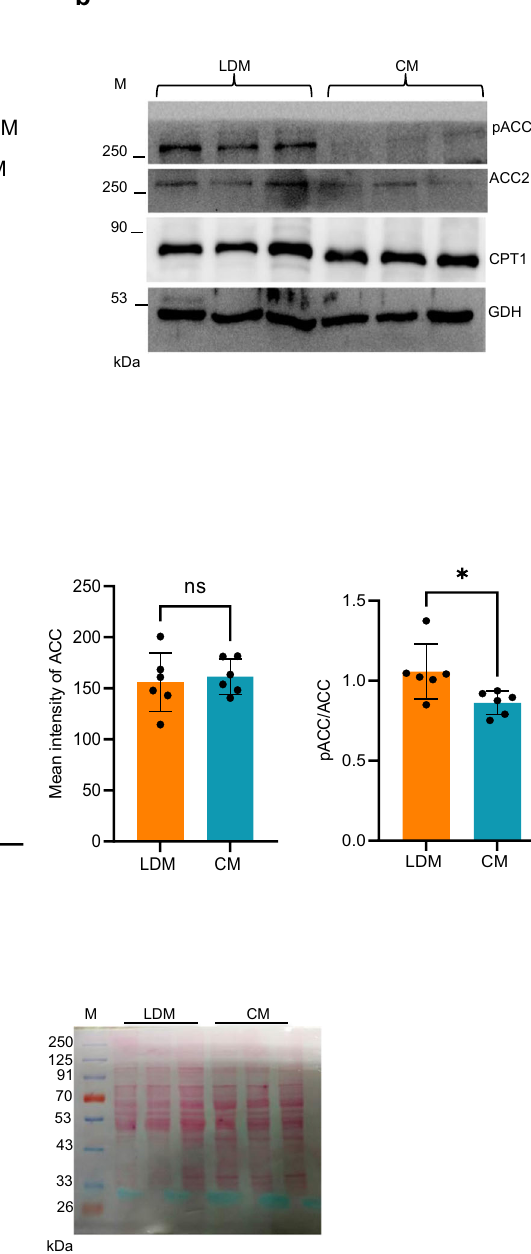
Fig. 3 | Lipid Droplet associated Mitochondria (LDM) from rat liver is specia- lized to perform Fatty Acid Oxidation (FAO) during an ad-libitum food condi- tion. a – d Lipid Droplet associated mitochondria (LDM) and Cytoplasmic Mitochondria(CM). a LDMhasahigherFAOthanCM.Quanti fi cationofFAO( n =4) intermsofoxygenconsumptionperformedinisolatedLDMandCMasdescribedin the Methods section in the presence of oleic acid (OA), and OA+FCCP (maximal respiration induced by chemical un-coupler FCCP). Data are presented as mean values±SD. Signi fi cance was calculated by two tailed un-paired Student t -test. **p =0.005, ****p =0.00004. b LDM is marked by high pACC2. Shown here is a